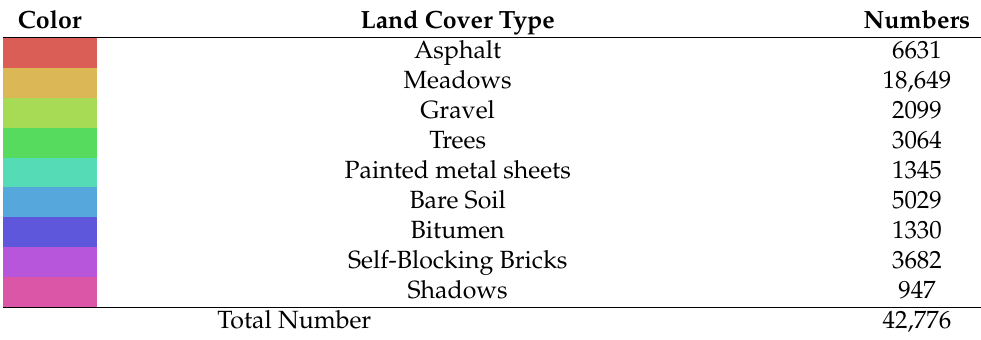
Table 3. background color and number of land cover classes on Pavia university.